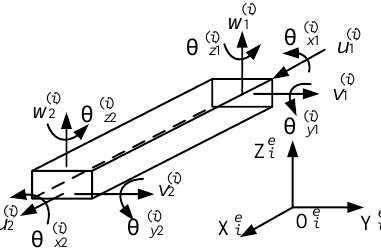
Figure 6. Spatial beam element in local coordinate system.